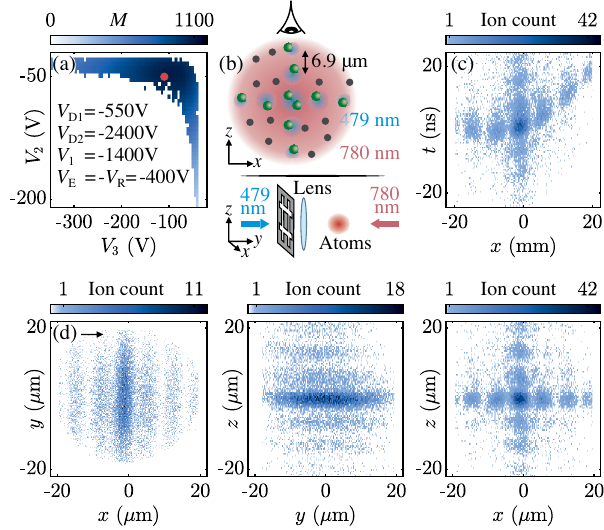
FIG. 7. Three-dimensional imaging. (a) Transverse magnifica- tion for a reduced magnitude of V , boosting the axial D 1 resolution. All electrode voltages are given in the plot. (b) Proof-of-principle experiment to test the 3D imaging. The light field of the 479-nm photoionization laser is spatially structured by projecting the diffraction pattern of two crossed double slits onto the atoms. (c) Imaging result in detector coordinates ( xt plane) for an electrode voltage configuration corresponding to the red mark ( V 2 ¼ − 50 V, V 3 ¼ − 110 V) shown in panel (a). The arrival time of the ions is corrected for an offset. As predicted from simulations, a curvature of the time of flight is observed. (d) Imaging result in object coordinates (all planes) after compensating for the curvature of the time of flight. In both panels (c) and (d), an integration of all ion counts is performed along the dimension not